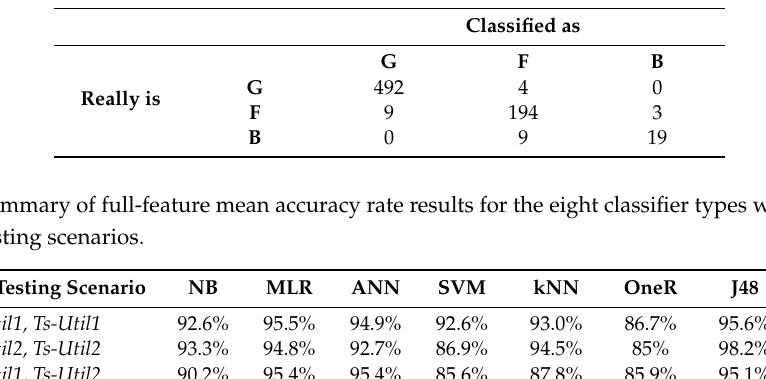
Table 3. Confusion matrix for the Tr-Util1 , Ts-Util1 scenario using the Random Forest classifier.